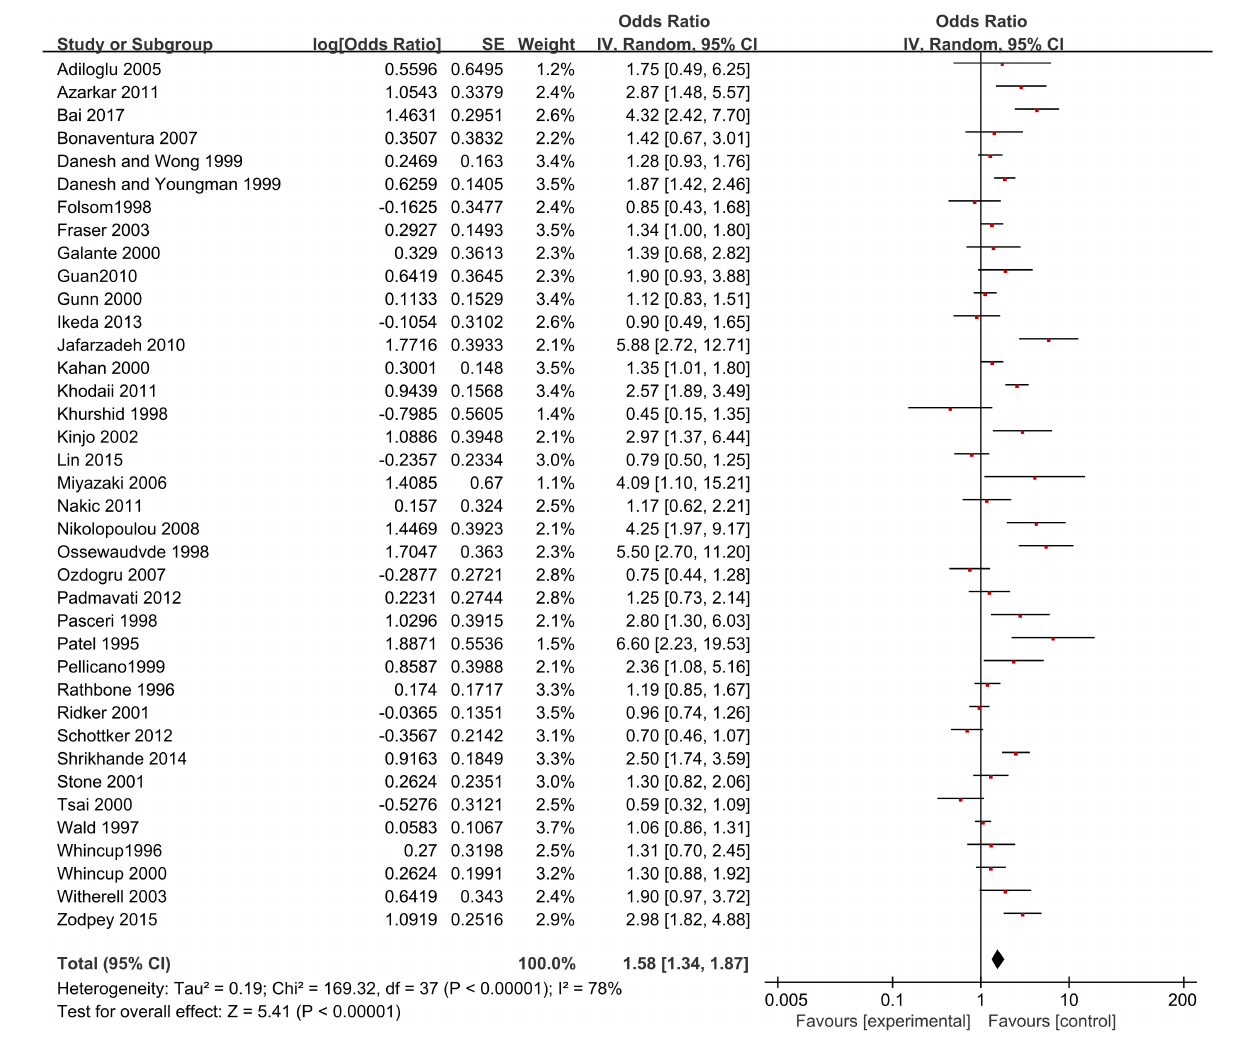
FIGURE 2 | Relationship anti- H. pylori IgG test and coronary heart disease [CHD; studies reporting OR + studies reporting hazard ratio (HR)].